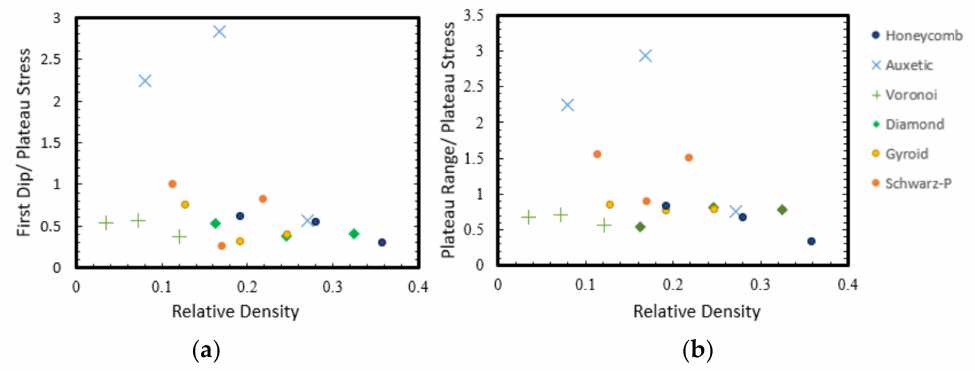
Figure 23. Plateau undulation quantified as ( a ) normalized first dip, and ( b ) normalized plateau range.